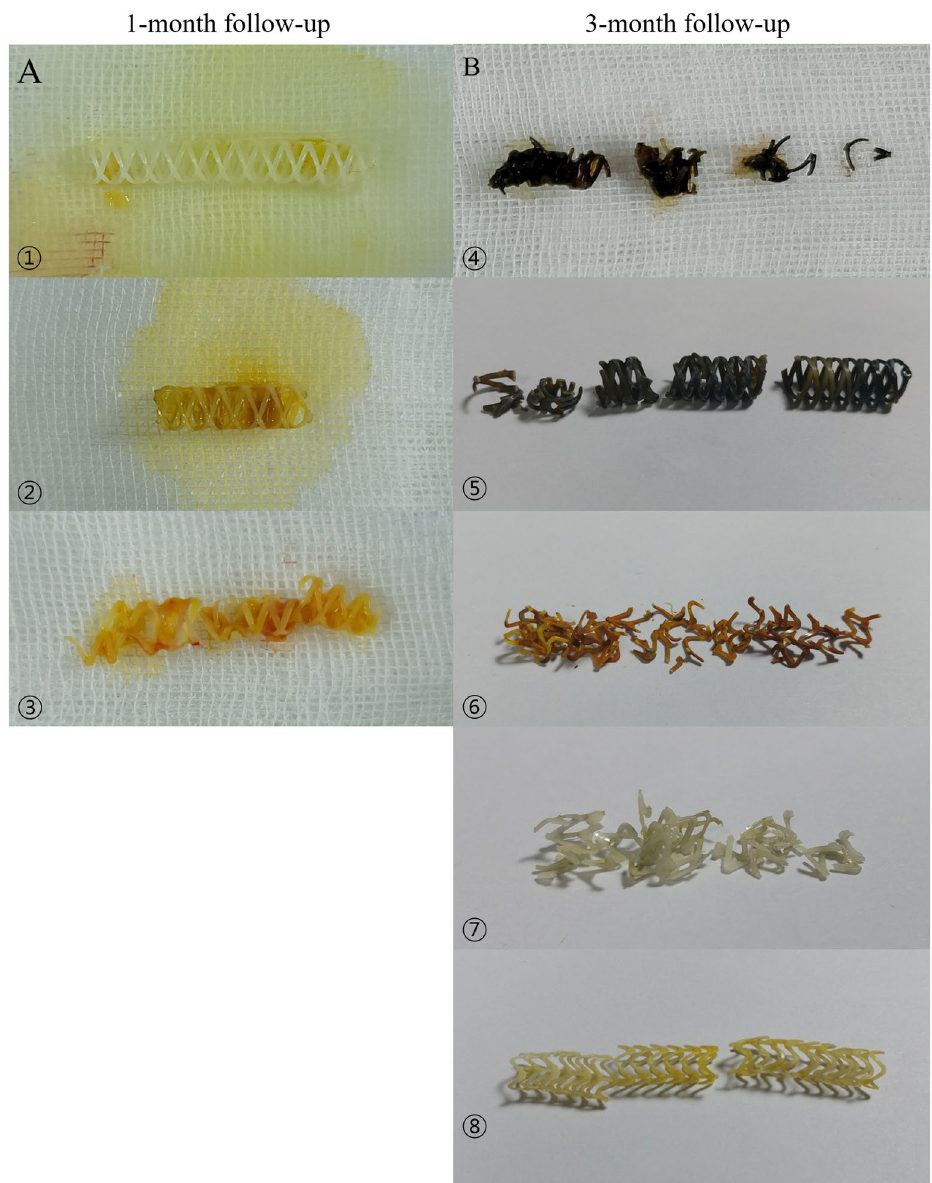
Figure 7. Gross morphology of polycaprolactone stents 1 month and 3 months after insertion. ( A ) Most stents maintain color and integration, 1 month after insertion. Specimen 3 was damaged by surgical instruments during common bile duct extraction. ( B ) At 3 months after stent insertion, most stents show discoloration and fragmentation. Specimens 6, 7, and 8 are prototype stents.